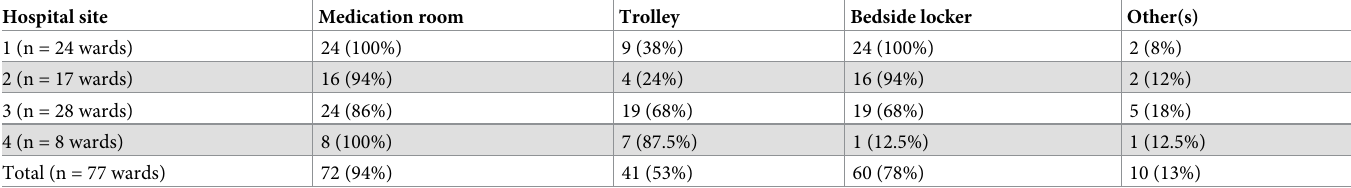
Table 1. Medication storage facilities on wards across the four hospital sites.